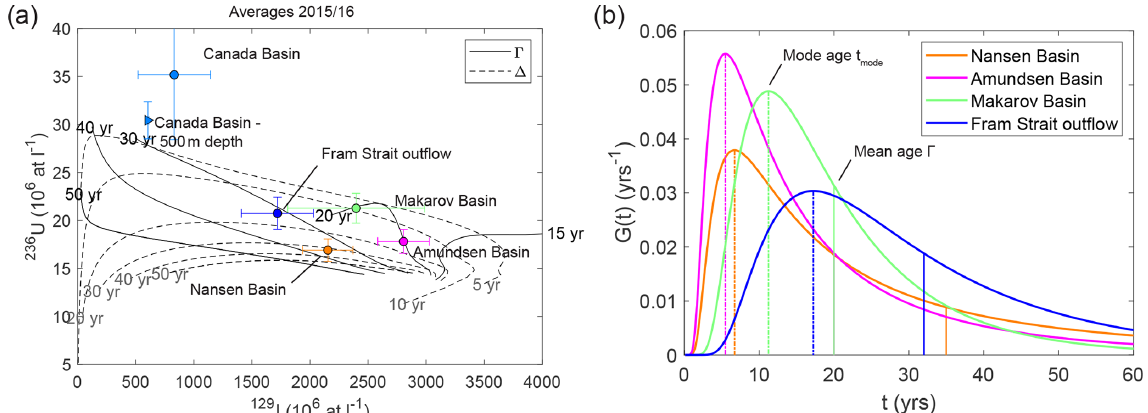
Figure 5. (a) (cid:48) (solid) and (cid:49) (dashed) isolines in the TTD model ( 236 U vs. 129 I) calculated assuming an inverse Gaussian TTD (sampling year 2015) and the Atlantic layer input function. Samples from 2015 and 2016 (250–800m depth) were sorted by basin (see Table S1) and averaged; the average values and corresponding standard deviations are plotted on top of the isolines. (b) Inverse Gaussian TTDs for the different Arctic basins based on the (cid:49) and (cid:48) values determined from (a) . Dotted vertical lines indicate the mode age and solid lines the mean age for each